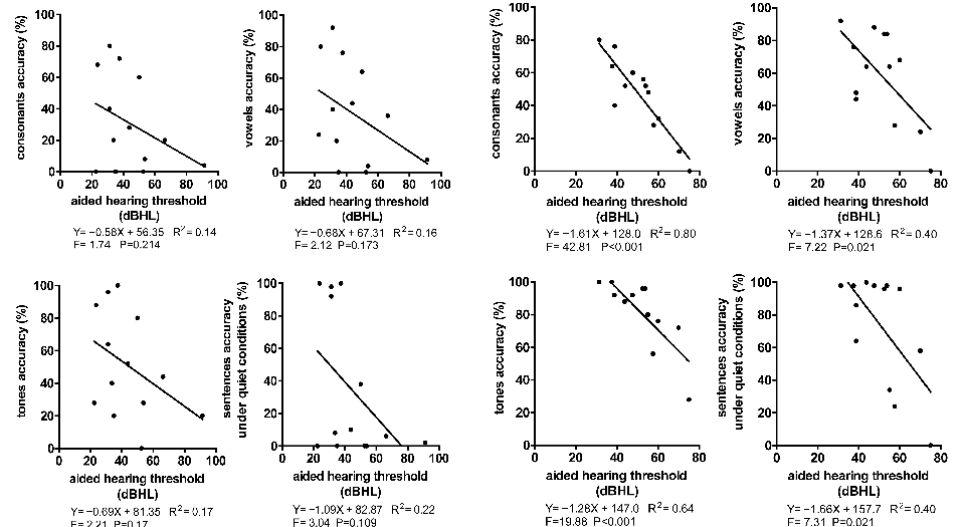
Figure 3. The linear relationship between AHT and SPA in 16 subjects with cochlea and HA dual mode. The left four subparagraphs are the CI side, the right four subparagraphs are the HA side. R 2 represents the goodness of fit, and F was the result of the variance test for the regression model. p < 0.05 indicates a linear relationship between AHT and SPA.